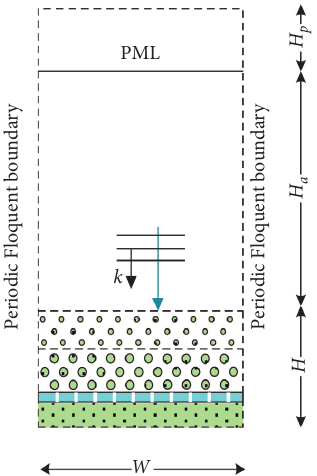
Figure 3: Geometric schematic of the finite element model of the matching layer.